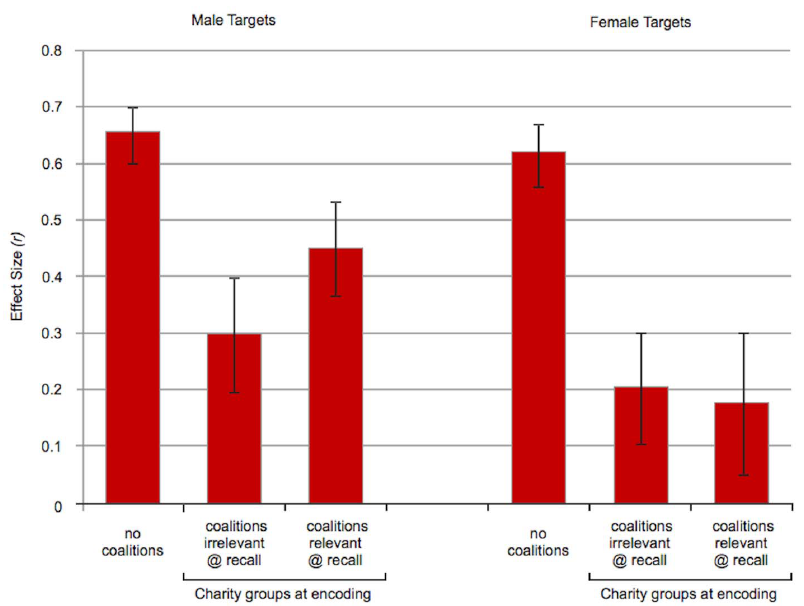
Figure 6. Racial categorization when coalition membership is marked by visual and behavioral cues (Studies 1 and 5). Race is crossed with shirt color in all of these conditions. Effect sizes for racial categorization are shown for male targets (left panel) and female targets (right panel). In each panel, the leftmost bar (labeled ‘‘no coalitions’’) depicts racial categorization when coalitions were absent (Study 1)). The two bars to its right depict racial categorization when coalitions were present and marked by differences in shirt color (Study 5). Behavioral cues and visual cues to coalition membership were present at encoding for all the coalition conditions of Study 5. The sentences at recall varied across conditions: Their content was either relevant to coalition membership (‘‘coalitions relevant @ recall’’) or applicable to members of both coalitions (‘‘coalitions irrelevant @ recall’’). When each charity group is wearing different colored shirts, the recall context always has a least one cue that coalition membership is relevant to the targets (a visual cue). This single cue was enough to down-regulate racial categorization; there was no added benefit to having coalition-relevant sentences at recall. Racial categorization was as low in these conditions as in the gray ones with coalition-relevant sentences (Study 3). For female targets, race was ‘‘erased’’ in the color + coalitions-relevant condition, and almost so in the color + coalitions-irrelevant condition. Error bars: + / 2 1 S.E.